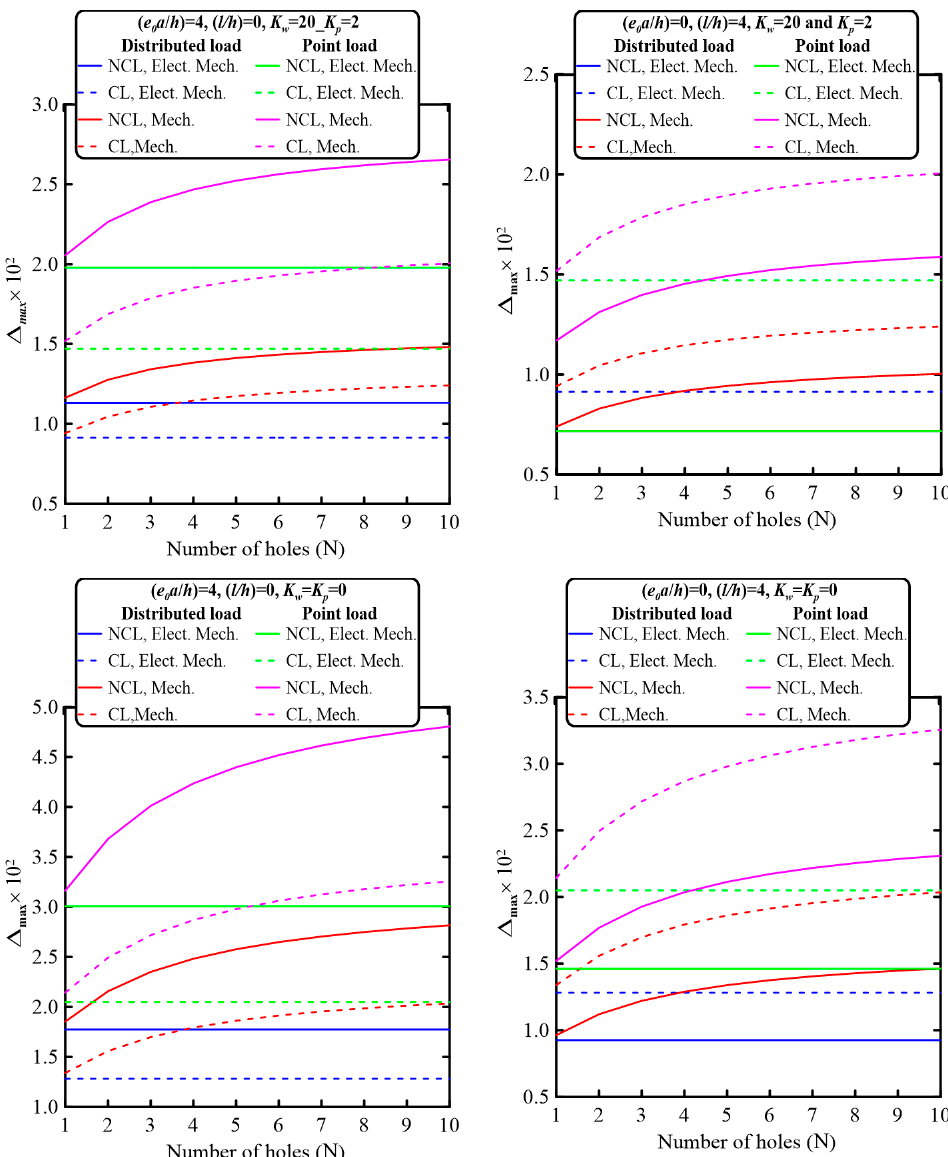
Figure 7. Variation in the maximum normalized transverse deflection ∆ max with the number of holes throughout the cross-section N for nonclassical and classical electromechanical and mechanical behavior under uniformly distributed and point loads at different values of the nonclassical and elastic foundation parameters at α = 0.5 and beam aspect ratio L / h = 20, N = 1 to 10, e 311 = − 4.1 C/m 2 , µ 3111 = 5 × 10 − 8 C/m, a 33 = 7.124 × 10 − 9 C/m 2 K, and K p = 0, 2 and K w = 0, 20. Keeping the value of perforation filling ratio constant, investigating the quantitative effect of the number of hole rows N on the maximum nondimensional transverse deflection, the relative percentage difference of the maximum nondimensional transverse deflection due to increasing N is defined as ( % D ∆ max ) . The relative percentage difference ( % D ∆ max ) for electromechanical and mechanical nonclassical N